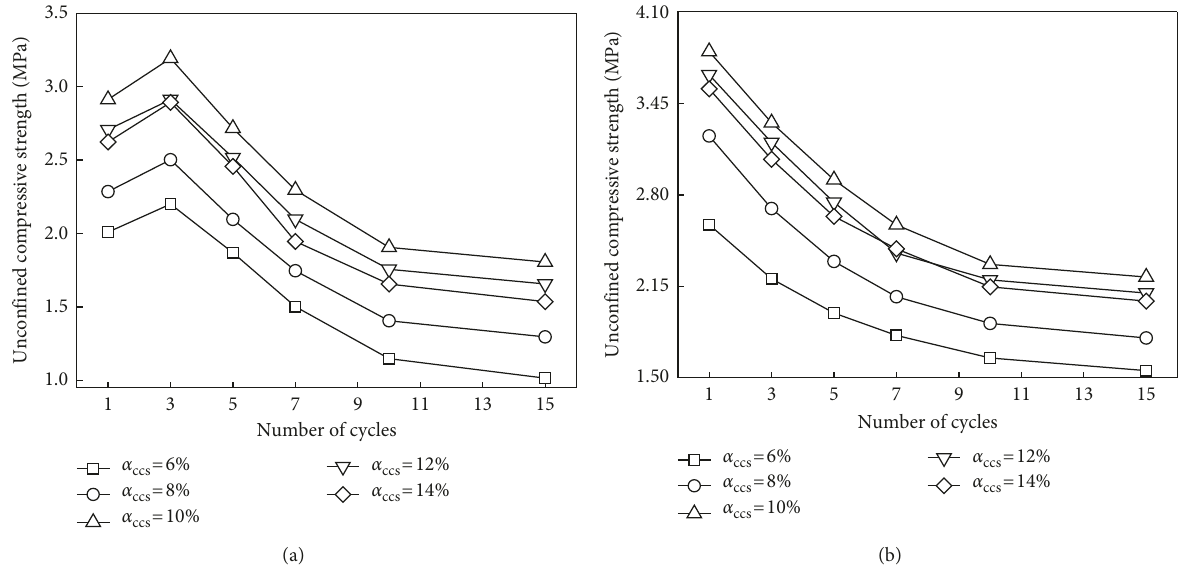
Figure 6: Evolutions of the unconfined compressive strength during the drying-wetting process. Curing time: (a) 14d and (b) 28d.